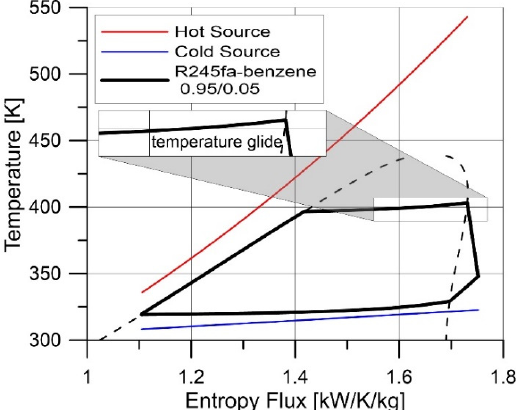
Figure 9. T-s diagram of an ORC with mixtures of working fluids [155]. Inset zoom on the temperature glide in the evaporation phase. Similar to the condensation one. Dashed line is the saturation curve of the fl uid mixture (R245fa/benzene 0.95/0.05)